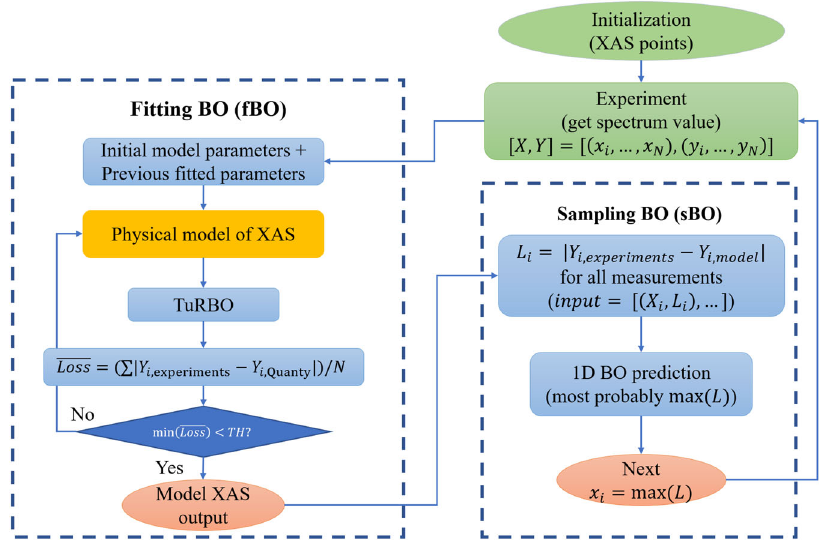
Fig. 6 Adversarial Bayesian Optimization (ABO) approach work fl ow. Starting with an arbitrary number of random initial energy points and their corresponding measured spectral values, two BO blocks are trained and updated competitively. The Fitting BO block fi ts the parameters of the Quanty model to identify the XAS curve that best matches the current measurements, while the Sampling BO block identi fi es the most likely point that could cause the fi tted physical model to